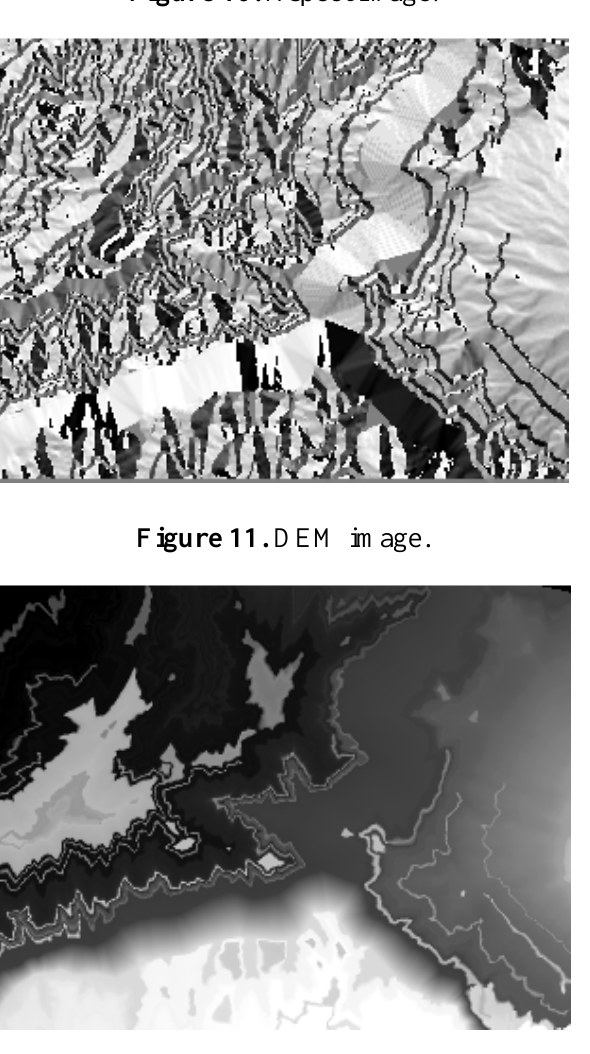
Figure 10. Aspect image .